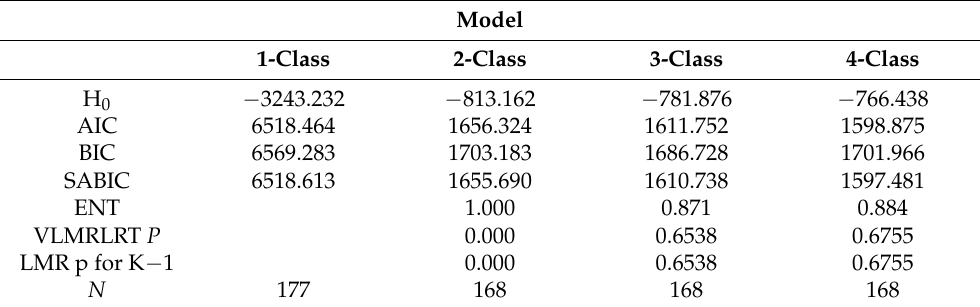
Table 3. Fit indices from one-class, two-class, three-class, and four-class mixture